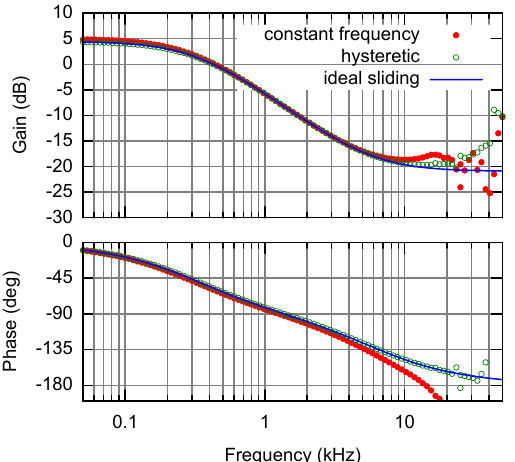
Figure 5. Theoretical and simulated frequency responses from the current reference to output voltage in a boost converter.